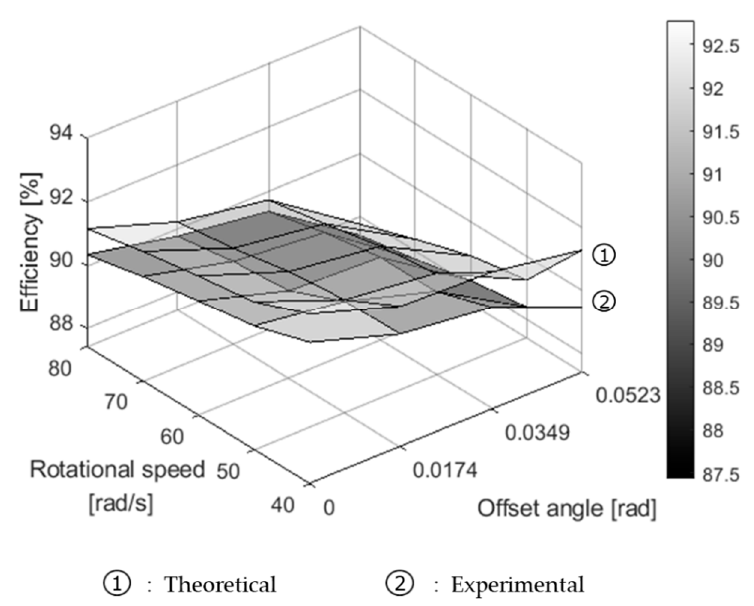
Figure 9. Transmission efficiency of theoretical and experimental results.